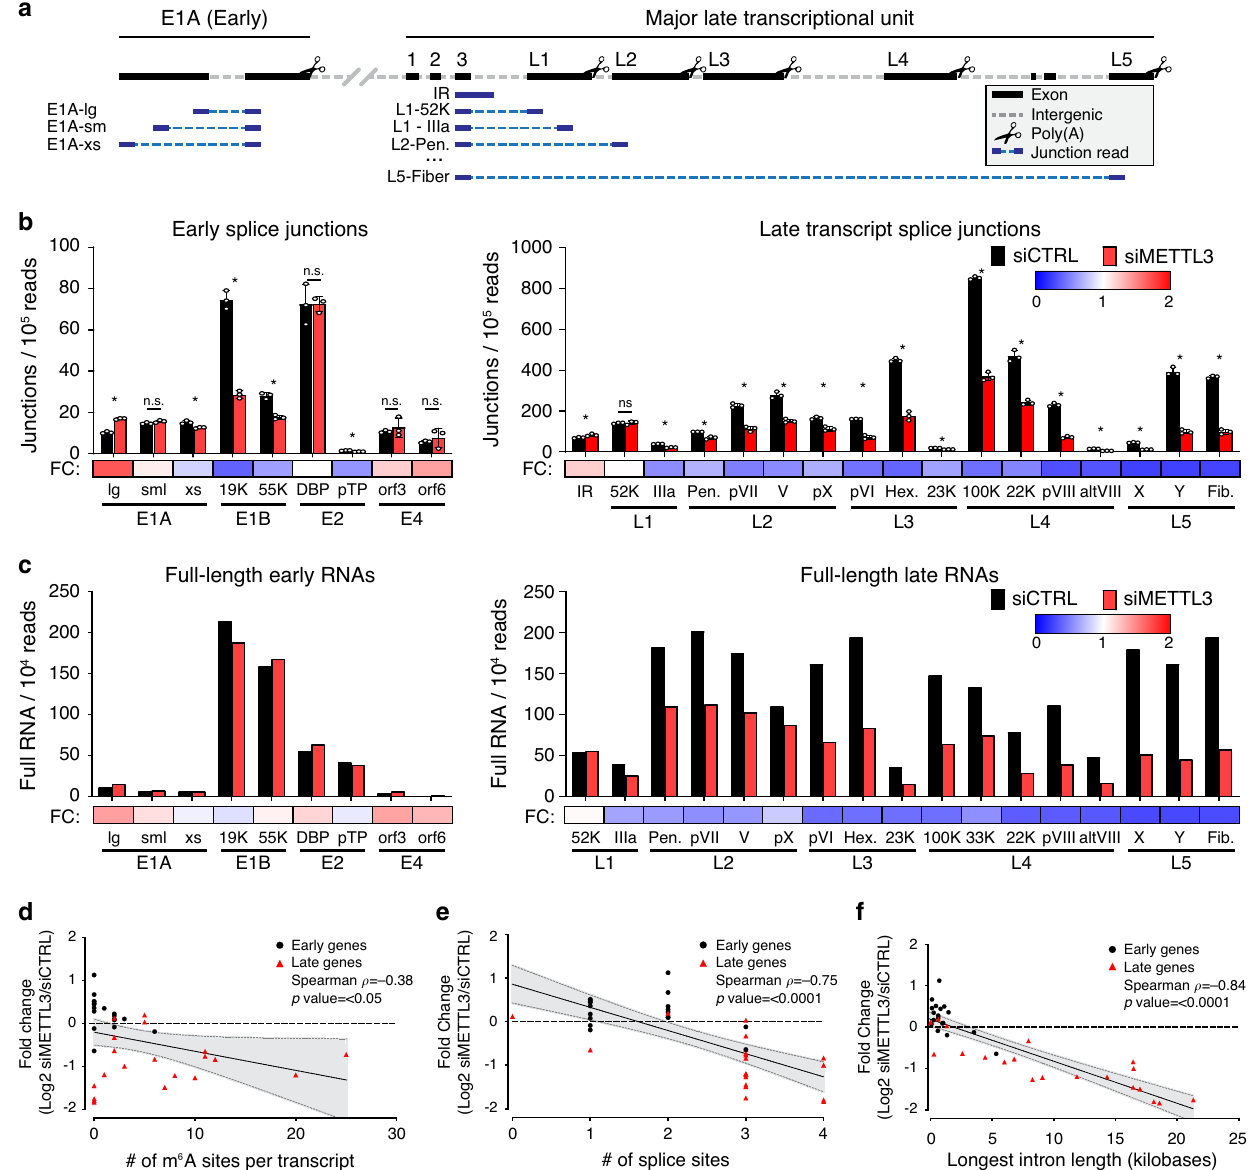
Fig. 7 METTL3 knockdown globally dysregulates adenoviral late RNA processing. a Schematic showing how junction-containing splice reads generated by Illumina sequencing can be used to predict speci fi c transcript abundances when genes overlap. Short reads (dark blue) aligning speci fi cally to viral exons (black) were fi ltered for the presence of a splice junction (dashed light blue line) that was only present in one viral transcript. b Splice junction containing reads indicative of adenovirus transcripts present in Illumina RNA-Seq data generated after infection of A549 cells where METTL3 was depleted by siRNA. Splice junction read depth was normalized to the total amount of reads mapping to both human and viral RNA per library. Early viral transcripts are shown on the left, MLP-derived late transcripts shown on the right. Fold-change (FC) between control siRNA and siMETTL3 for each transcript was plotted as a heatmap below the bar chart. Data depict three biological replicates with error bars showing standard deviation. For all assays signi fi cance was determined by unpaired two-tailed Student ’ s T -test, where * p ≤ 0.05 and ns = not signi fi cant. Graphs represent means + / − standard deviation. c Independently derived RNA was sequenced by ONT after METTL3 knockdown and adenovirus infection to yield full-length RNA sequences indicative of the labeled early and late viral transcripts. Fold-change (FC) between control siRNA and siMETTL3 for each transcript was plotted as a heatmap below the bar chart. d Individual viral transcripts are plotted as a function of log2 fold change of the siMETTL3/siCTRL data from Fig. 7c and the number of isoform-level m6A sites detected in Fig. 2a. Canonical early genes are coded with black squares and canonical late genes coded with red triangles, however the entire dataset was analyzed by Spearman ’ s correlation test to yield a correlation rho ( ρ ) value and signi fi cance p -value. e Analysis performed as in d , but with log2 fold change and the total number of splice sites contained within each viral transcript. f Analysis performed as in d , but with log2 fold change and the length (in nucleotides) of the longest intron contained within each viral transcript. For panels d – f the black line represents the calculated best- fi t linear regression, and the shaded gray area represents 95% con fi dence interval. Exact p -values are included in the source data fi